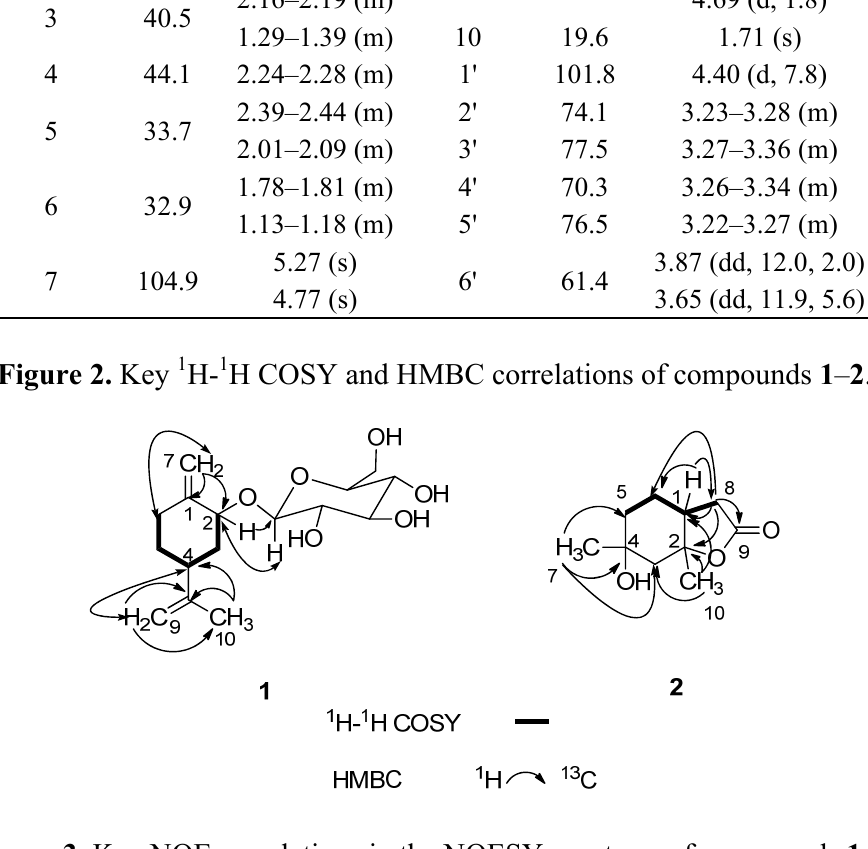
Figure 3. Key NOE correlations in the NOESY spectrum of compounds 1 – 2